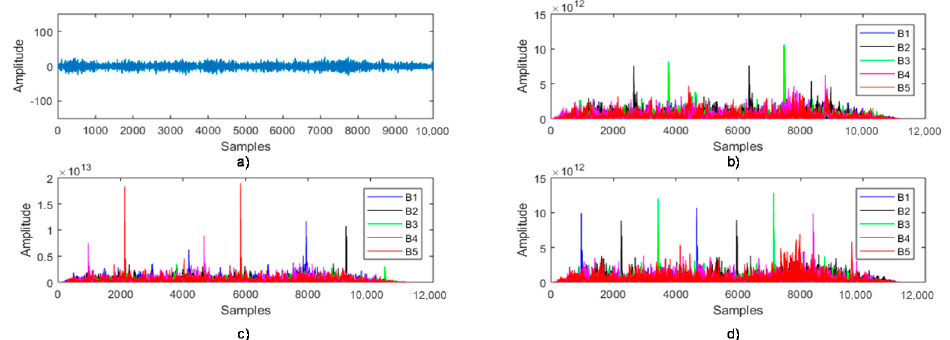
Figure 5. Example of the incoming acquired r A [ n ] in a single receiver ( a ), as well as the correlation functions for the three available ULPSs ( b – d ).